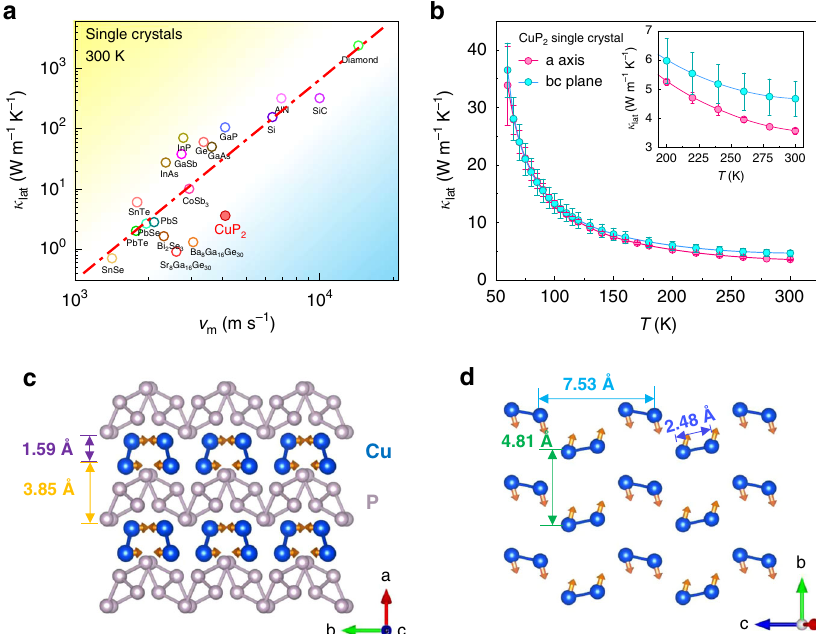
Fig. 1 Lattice thermal conductivity and crystal structure of CuP 2 . a A survey of lattice thermal conductivity of disorder-free materials vs. mean sound speed v m . The detailed data are listed in Supplementary Table 1 (for polycrystalline samples, please refer to Supplementary Fig. 1 and Table 2). b Temperature dependence of the lattice thermal conductivity of the CuP 2 single crystal is shown from 50 to 300 K measured by a steady-state comparative method. The inset shows the data near room temperature. The error bars indicate the uncertainty (see “ Methods ” ). c The layered structure with Cu dimer layers and P network layers are highlighted. The arrows in orange on Cu atoms represent the vibrational directions at the Γ point of the optical phonon mode located at about 11 meV (see Fig. 4). The atomic motions of this mode are also displayed in Supplementary Movie 1. d The isolated Cu dimer layers with intra- and inter-dimer distances